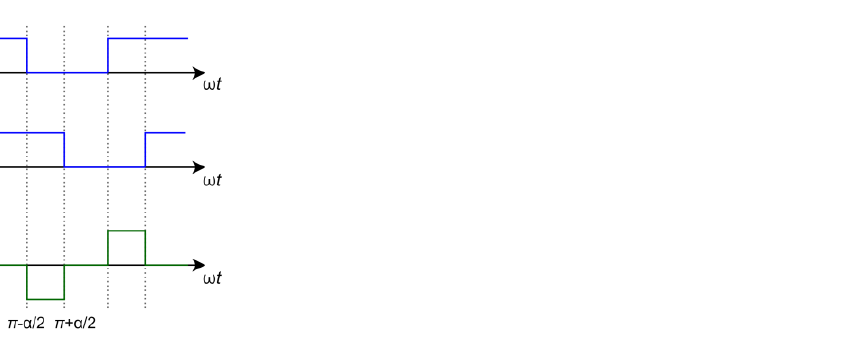
Figure 10. Waveforms example of the phase-shift modulation: MOSFET gate signals (blue) and inverter output voltage (green).